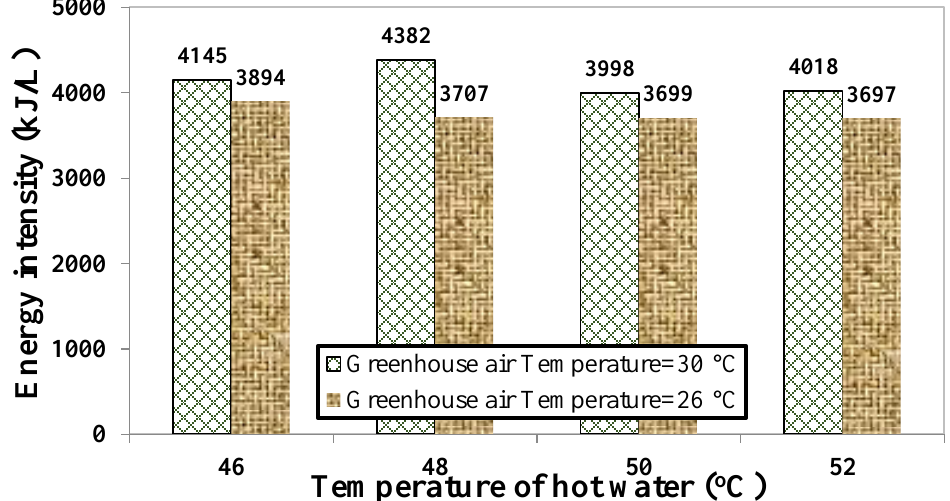
Figure 12. Energy intensity versus seawater and greenhouse air temperature.